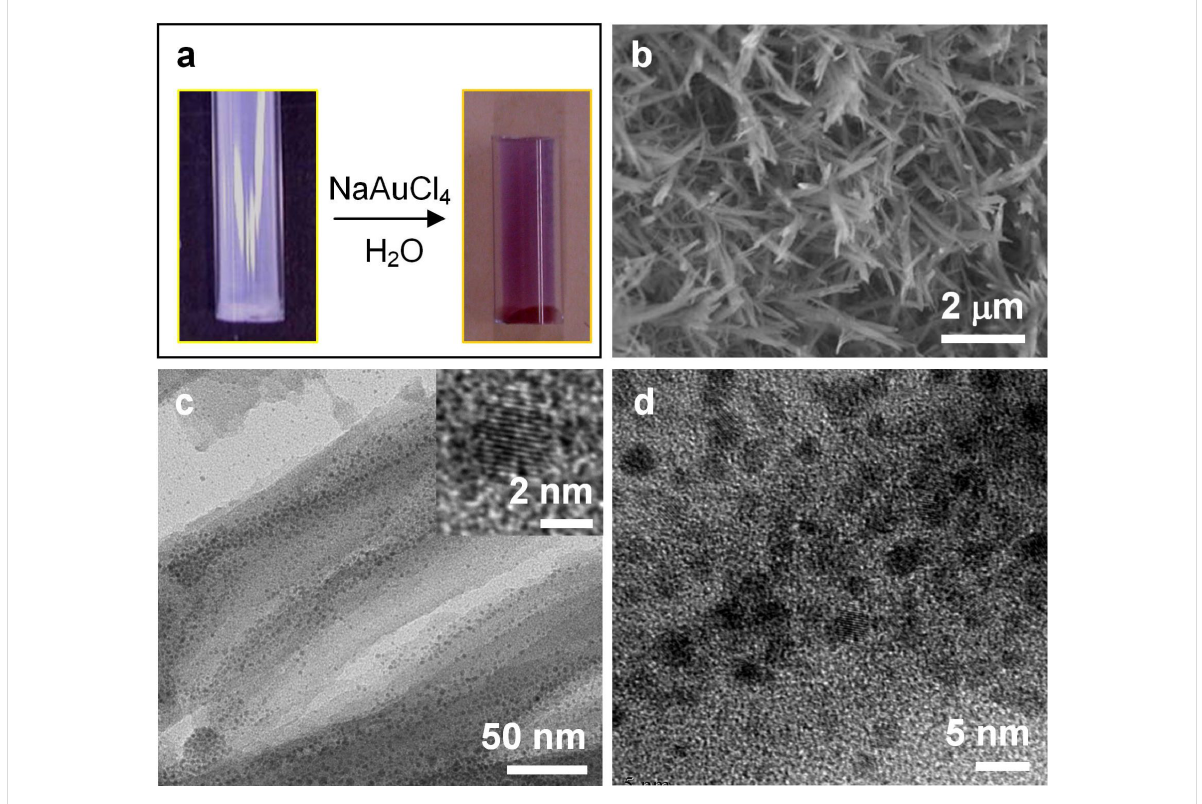
Figure 8: LPEI@silica nanograss surface decorated by Au nanoparticles. (a) Photographs of the nanograss on the inner surface of the tube before and after the formation of Au nanoparticles. SEM (b) and TEM (c and d) images of LPEI@silica@Au nanoparticles–nanograss surface synthesized by immersion of the LPEI@silica nanograss into an aqueous solution of NaAuCl 4 (1.0 wt %) at 80 °C for 60 min. The inset of (c) is the high-resolution TEM image of a randomly selected Au nanoparticle, showing the well-resolved Au crystalline